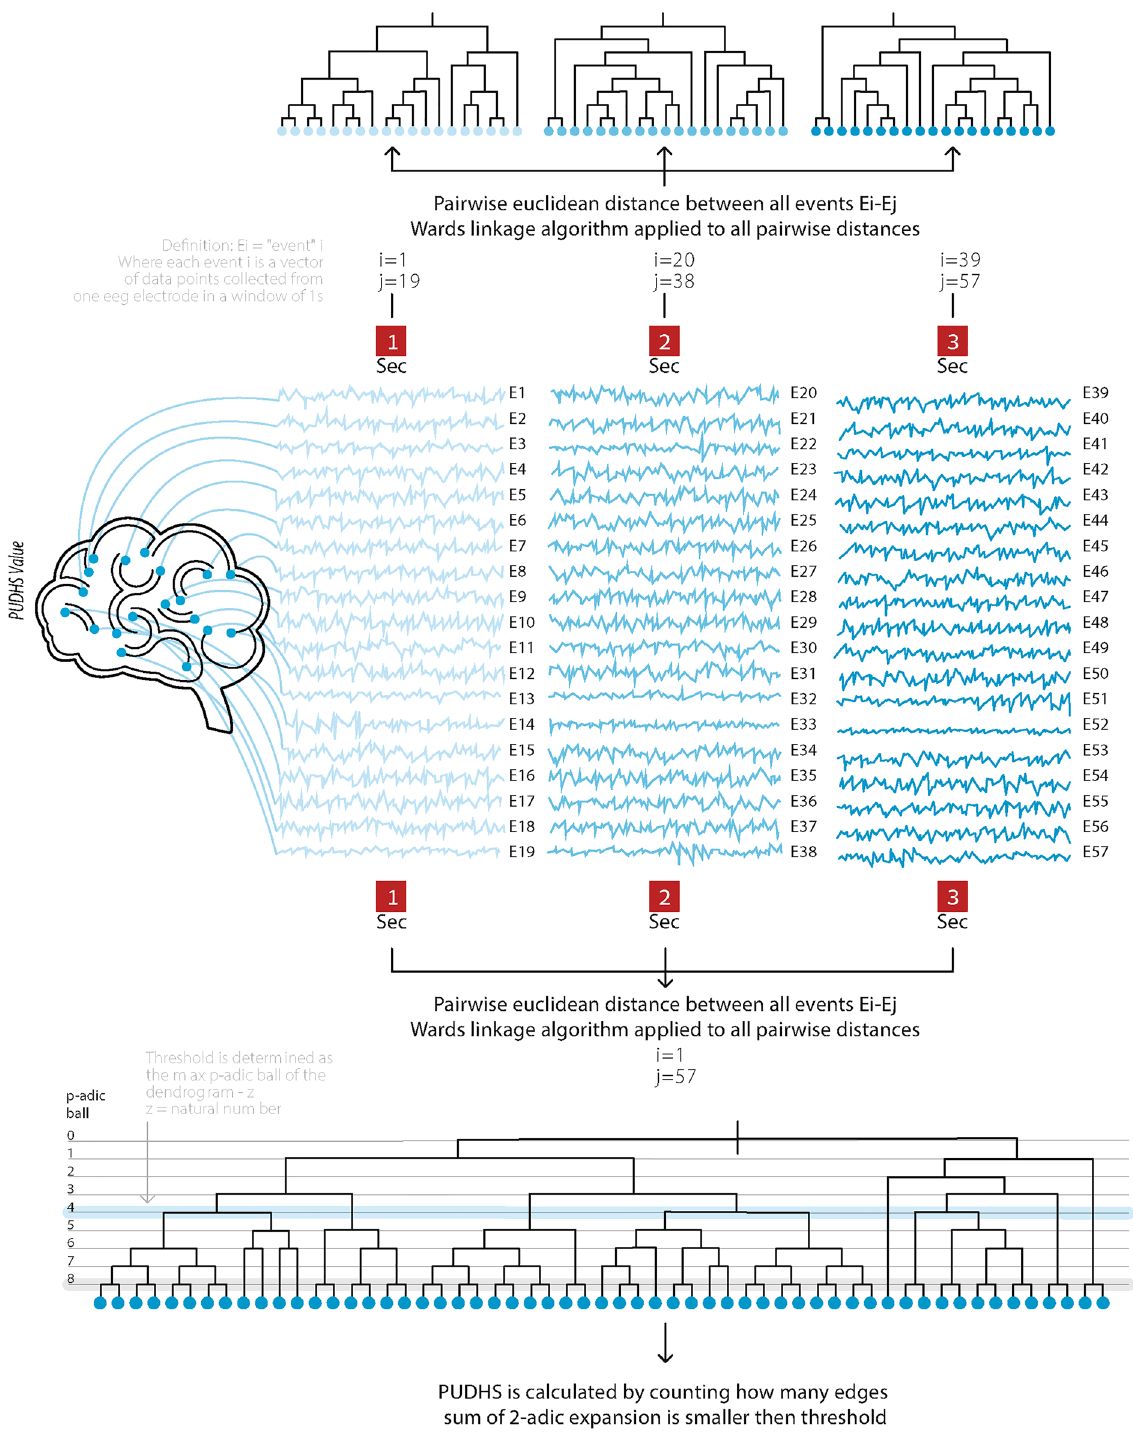
Figure 1. From EEG signal via dendrograms to PUDHS values—an illustration. A simple example showing a time series of 3 dendrograms (up) from three 1 s widows. Each dendrogram has 19 branches corresponding to the 19 electrodes. lower dendrogram was constructed by pairwise distances of 57 segments of EEG data meaning (3 windows × 19 segments in each window). PUDHS values are calculated by counting how many branches sum of 2-adic expansion is lower than threshold (blue thick horizontal line at the bottom